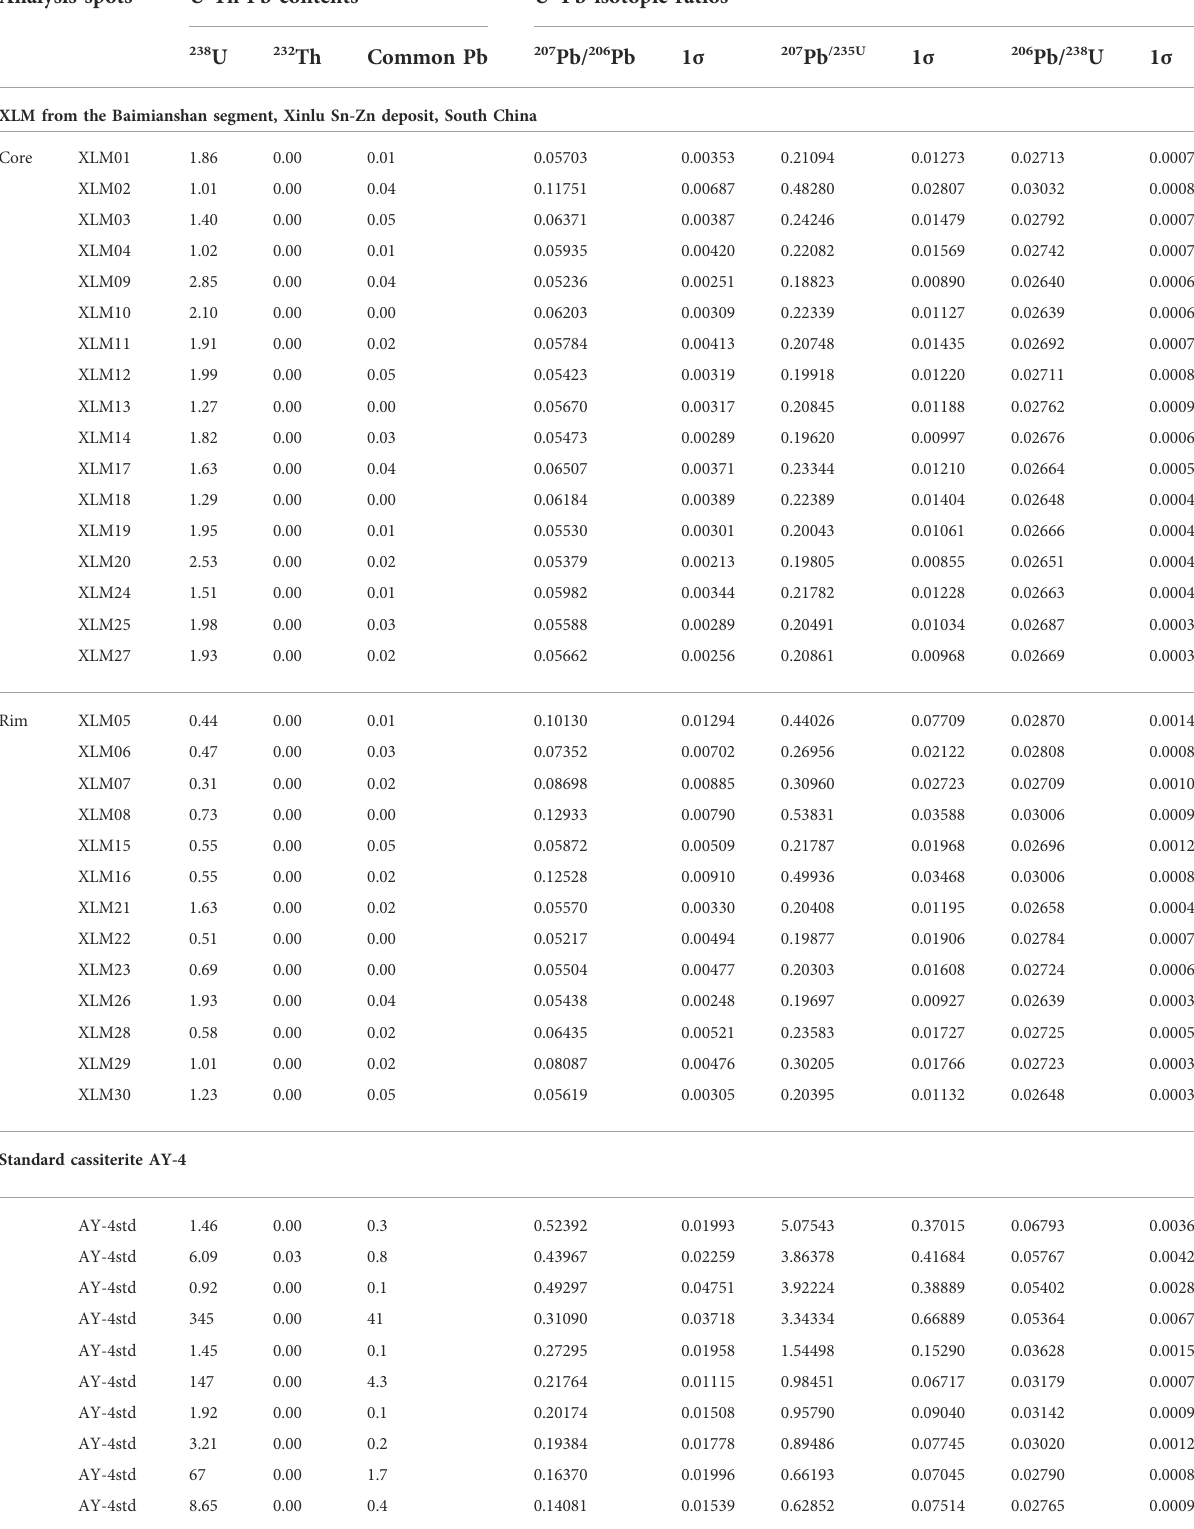
TABLE 1 LA-ICP-MS U-Pb dating results of cassiterite from the Baimianshan segment, Xinlu Sn-Zn deposit, South China. Analysis